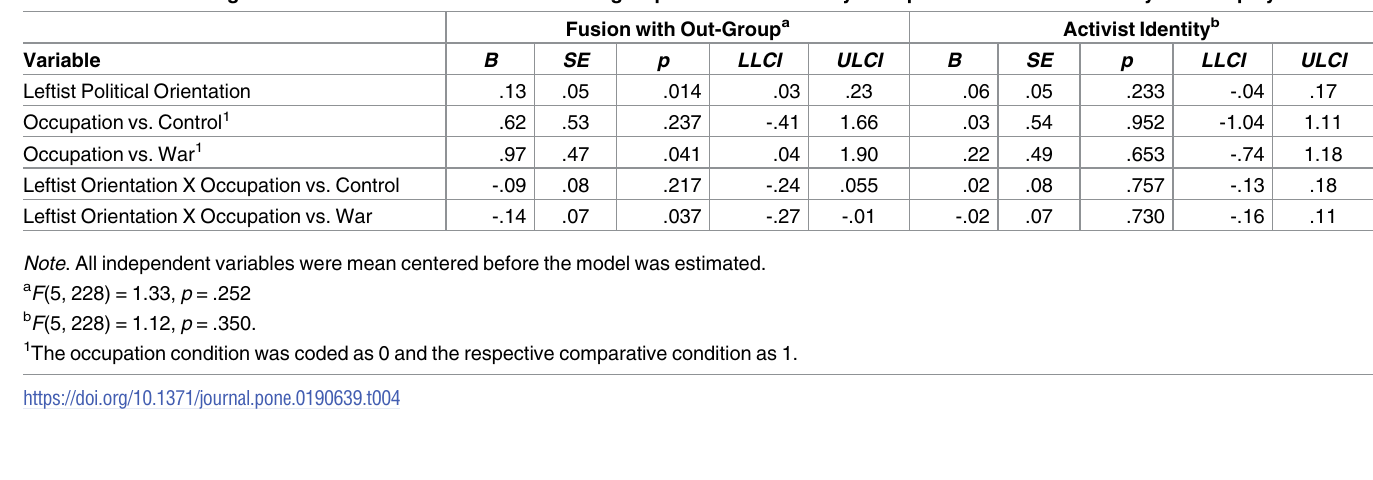
Table 4. Moderated regression models with fusion with the out-group and activist identity as dependent variables in Study 3 are